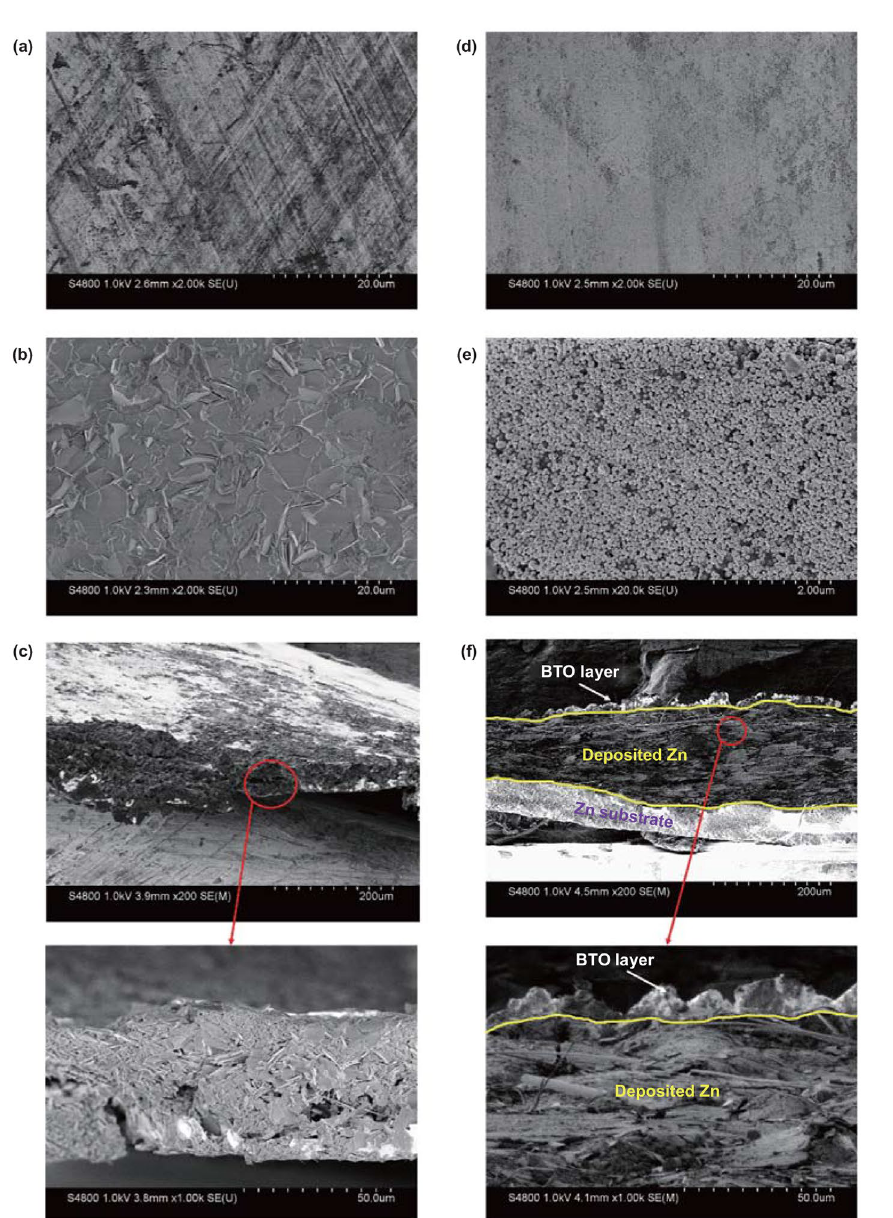
Fig. 3 SEM images of the anode morphology: a–c bare Zn and d–f BTO@Zn foils. a , d before and b , c and e , f after 100 cycles at 1 mA cm −2 and 1 mAh cm −2 of the symmetric cells. Highlight typical cross section SEM images in c and f . BTO layer, deposited Zn and Zn foils are sepa- rated by the yellow lines. (Color figure